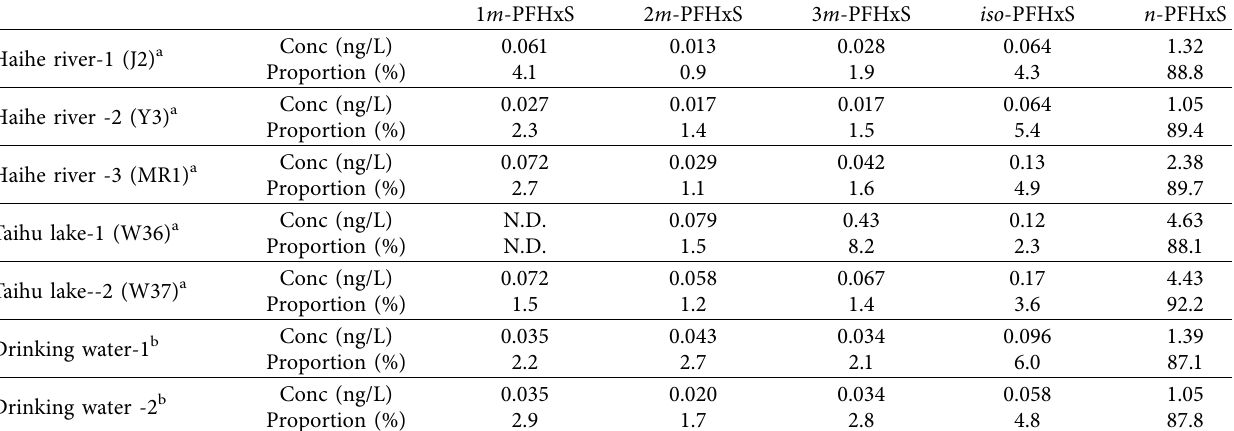
Table 5: Concentration and compositions of water